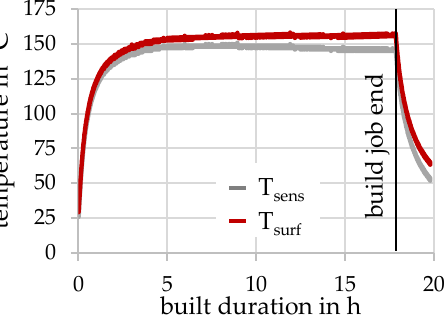
Figure 5. Temperature measured below the built plate and estimated surface temperature.